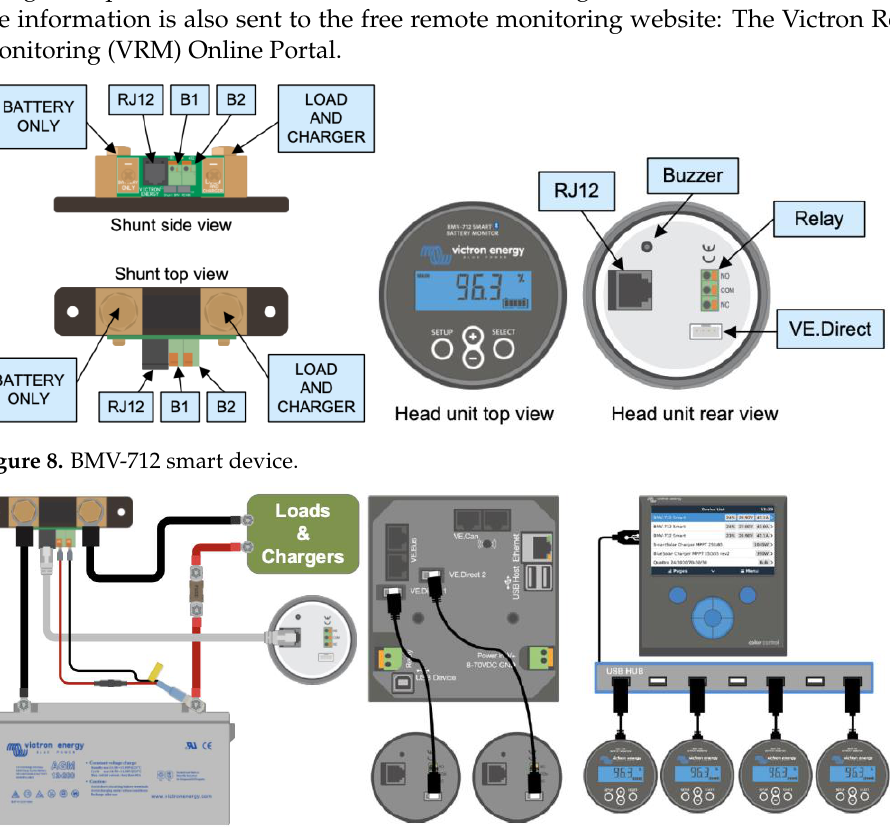
Figure 9. BMV-712 smart device installation.